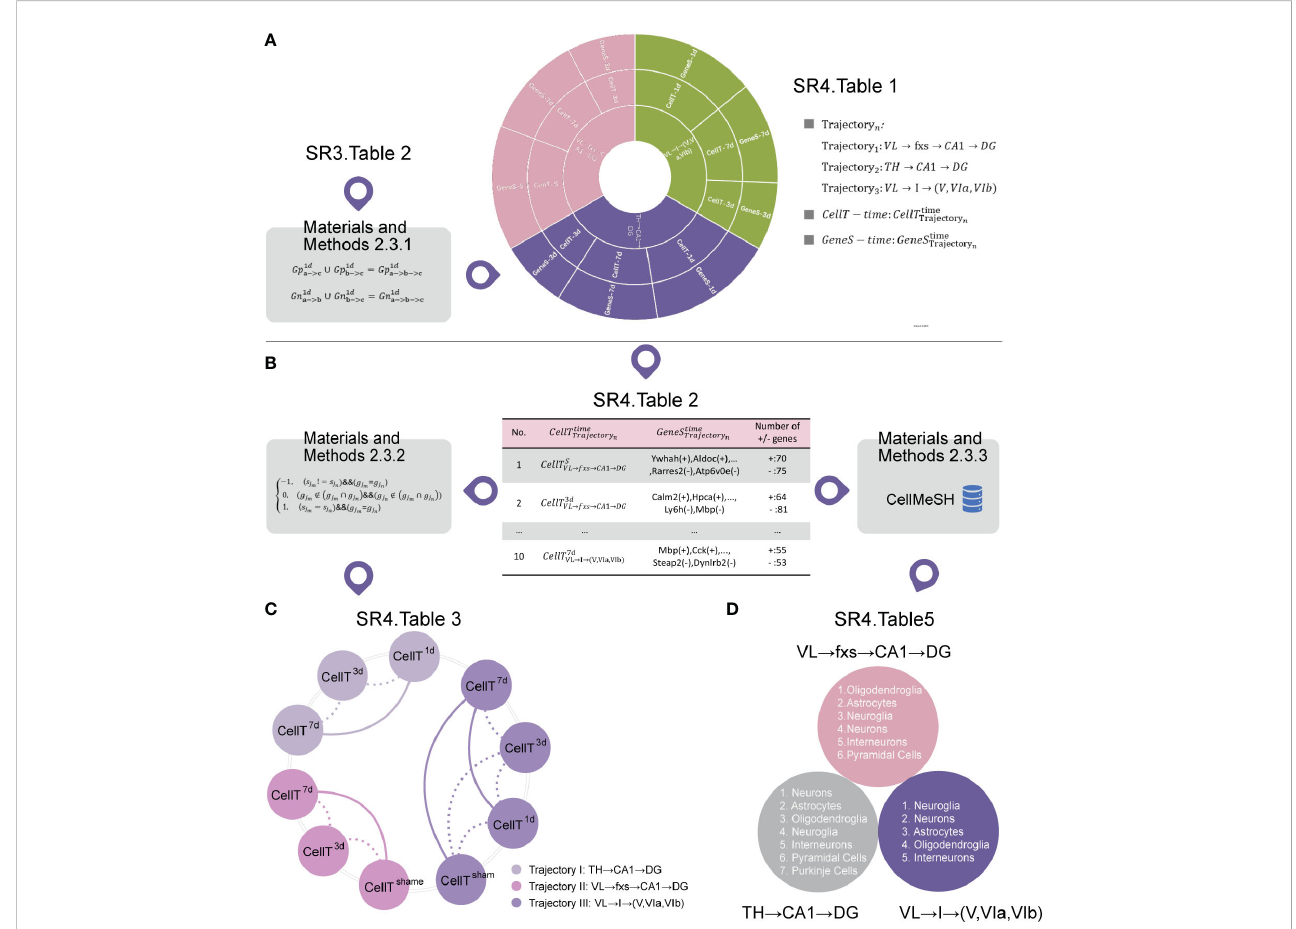
FIGURE 4 Cell subtype analysis. (A) The cell subtypes corresponding to the selected trajectory at different time points. (B) The marker gene sets of cell subtypes corresponding to the selected trajectory at different time points (SR4 Table 2). (C) Similarity analysis of cell subtypes at different time points within the same trajectory (SR4 Table 3). Among them, the thick line represents a high similarity between two time points, and the thin line represents a low similarity between two time points. (D) The cell types shared by our identi fi ed cell subtypes at different times within the same trajectory (SR4 Table